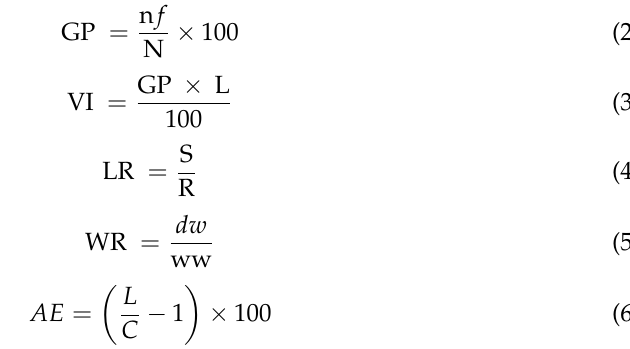
Chromatogram of the MAC; Figure S6: GC DIF Chromatogram of the MAE; Figure S7: 13 C NMR Spectrum of 66 ; Figure S8: 1 H NMR Spectrum of 66 ; Figure S9: HMBC Spectrum of 66 ; Figure S10: HSQC Spectrum of 66 ; Figure S11: COSY Spectrum of 66 ; Figure S12: NOESY Spectrum of 66